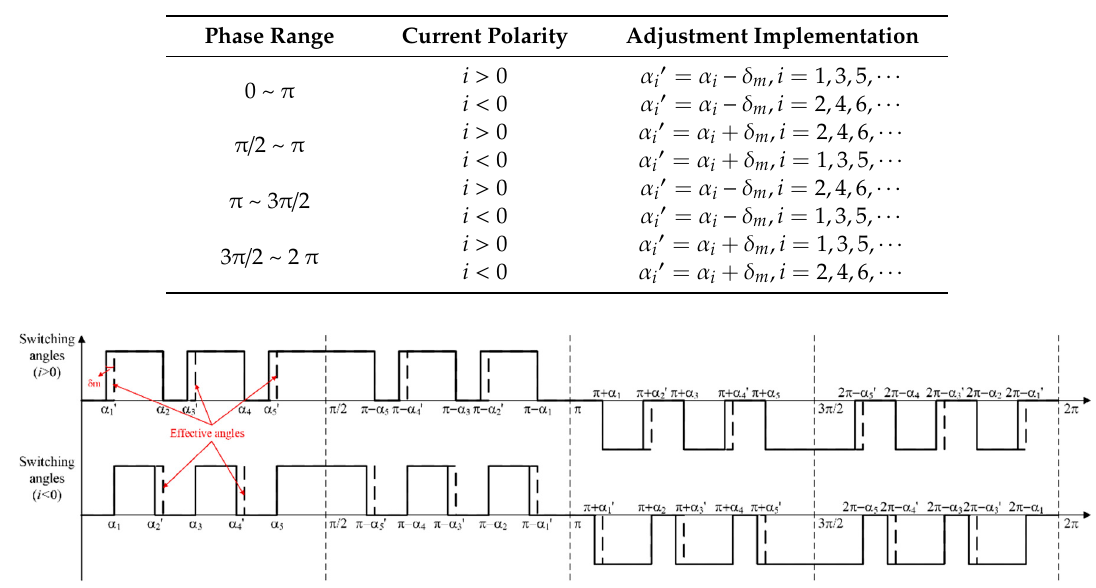
Figure 12. Method of inserting the margin time into the effective switching angles according to different polarity of current.